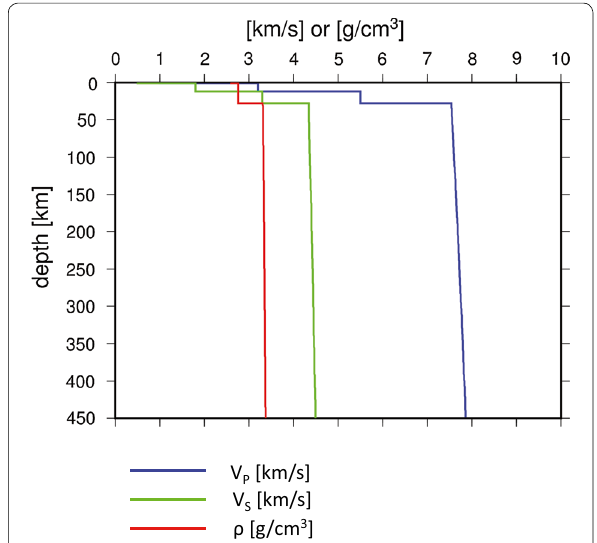
Fig. 5 1-D velocity and density model (depth profiles) for the Moon simulation